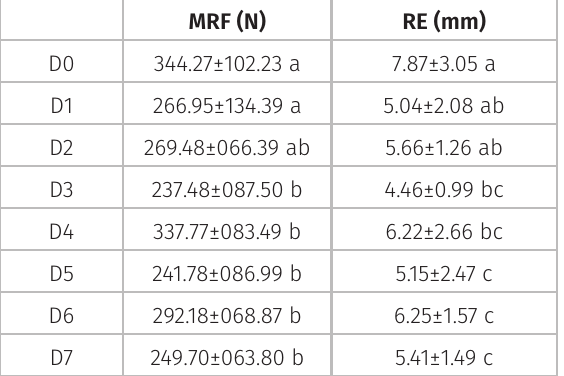
D0: fresh samples / without preservatives; D1 to D7: 1 to 7 days of storage. Means followed by the same letter in the same column do not differ by Tukey’s test